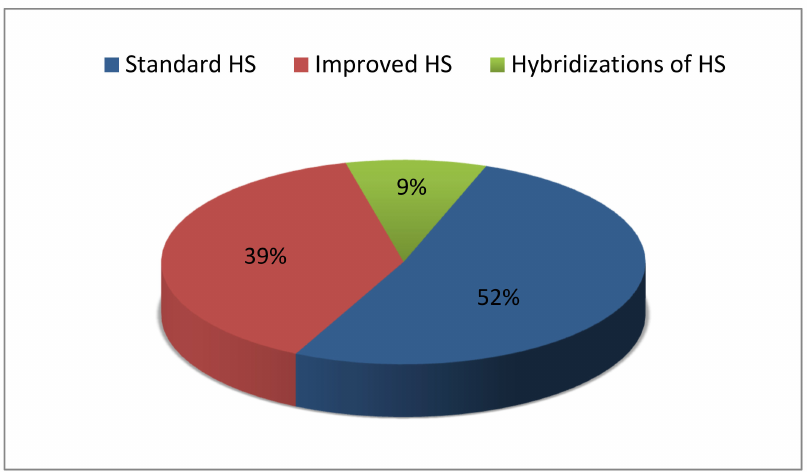
Figure 8. Variants distribution of HS algorithm equipped with FL in the reviewed papers (2007~22 August